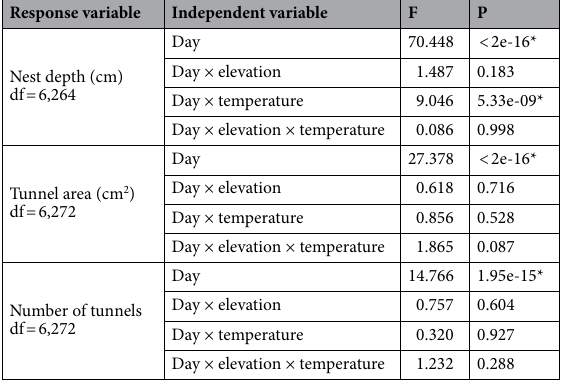
Table 2. Repeated measures ANOVA results for all seven days of the experiment. The interaction of day and temperature is significant for nest depth. *Significant, ⍺ = 0.05.